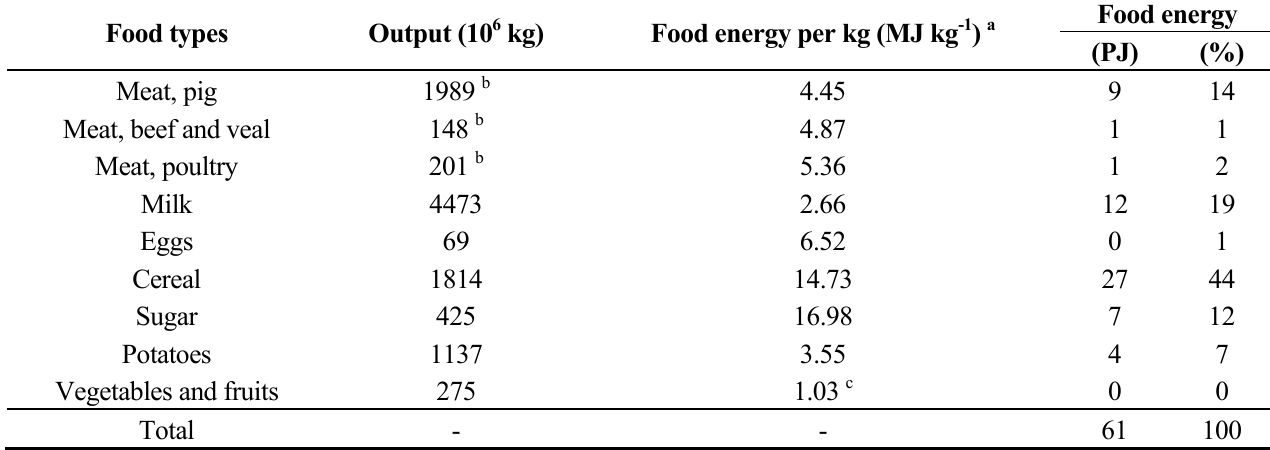
Table 5. Gross annual production of food in weight and food